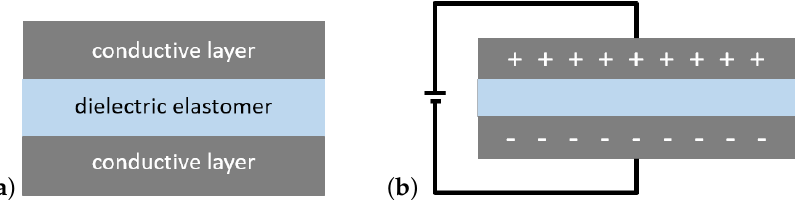
Figure 1. Schematics show a cross-sectional view of a DEA in ( a ) its relaxed state and ( b ) actuated state when the voltage is applied. The black parts represent the conductive parallel layers and the grey part represents the dielectric